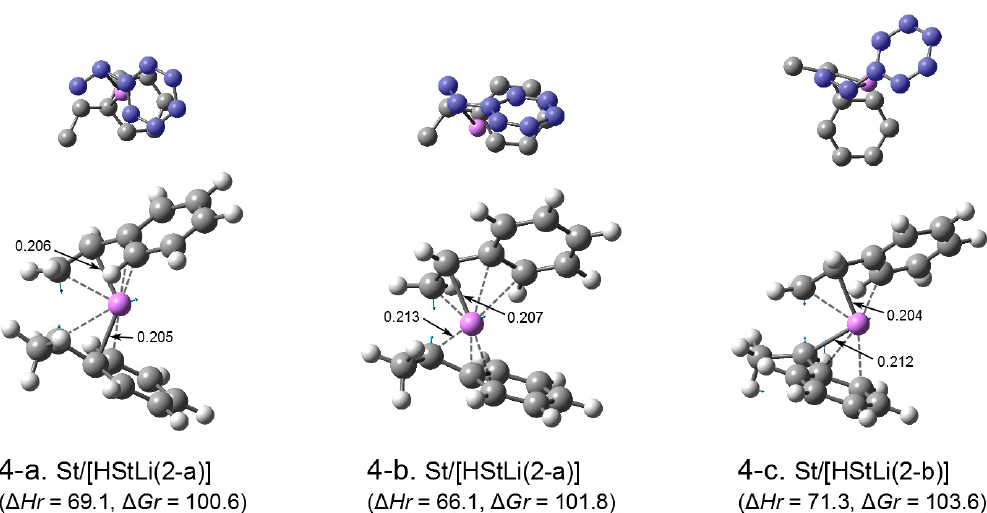
Figure 4-1. Transition states for the addition of styrene to HStLi(2-a) and (2-b) in the gas phase. The small drawing on the upper part of each structure is the simplified overhead view of the lower drawing; the carbon atoms of styrene are colored in blue. In the lower drawings, the shortest distances between Li and the chain-end-unit carbon and between Li and styrene carbon are shown. The blue arrows in the lower drawings indicate the displacement vectors for the imaginary frequency of the transition state. ∆ Hr and ∆ Gr , the relative enthalpy and relative free energy, are expressed in kJ·mol –1